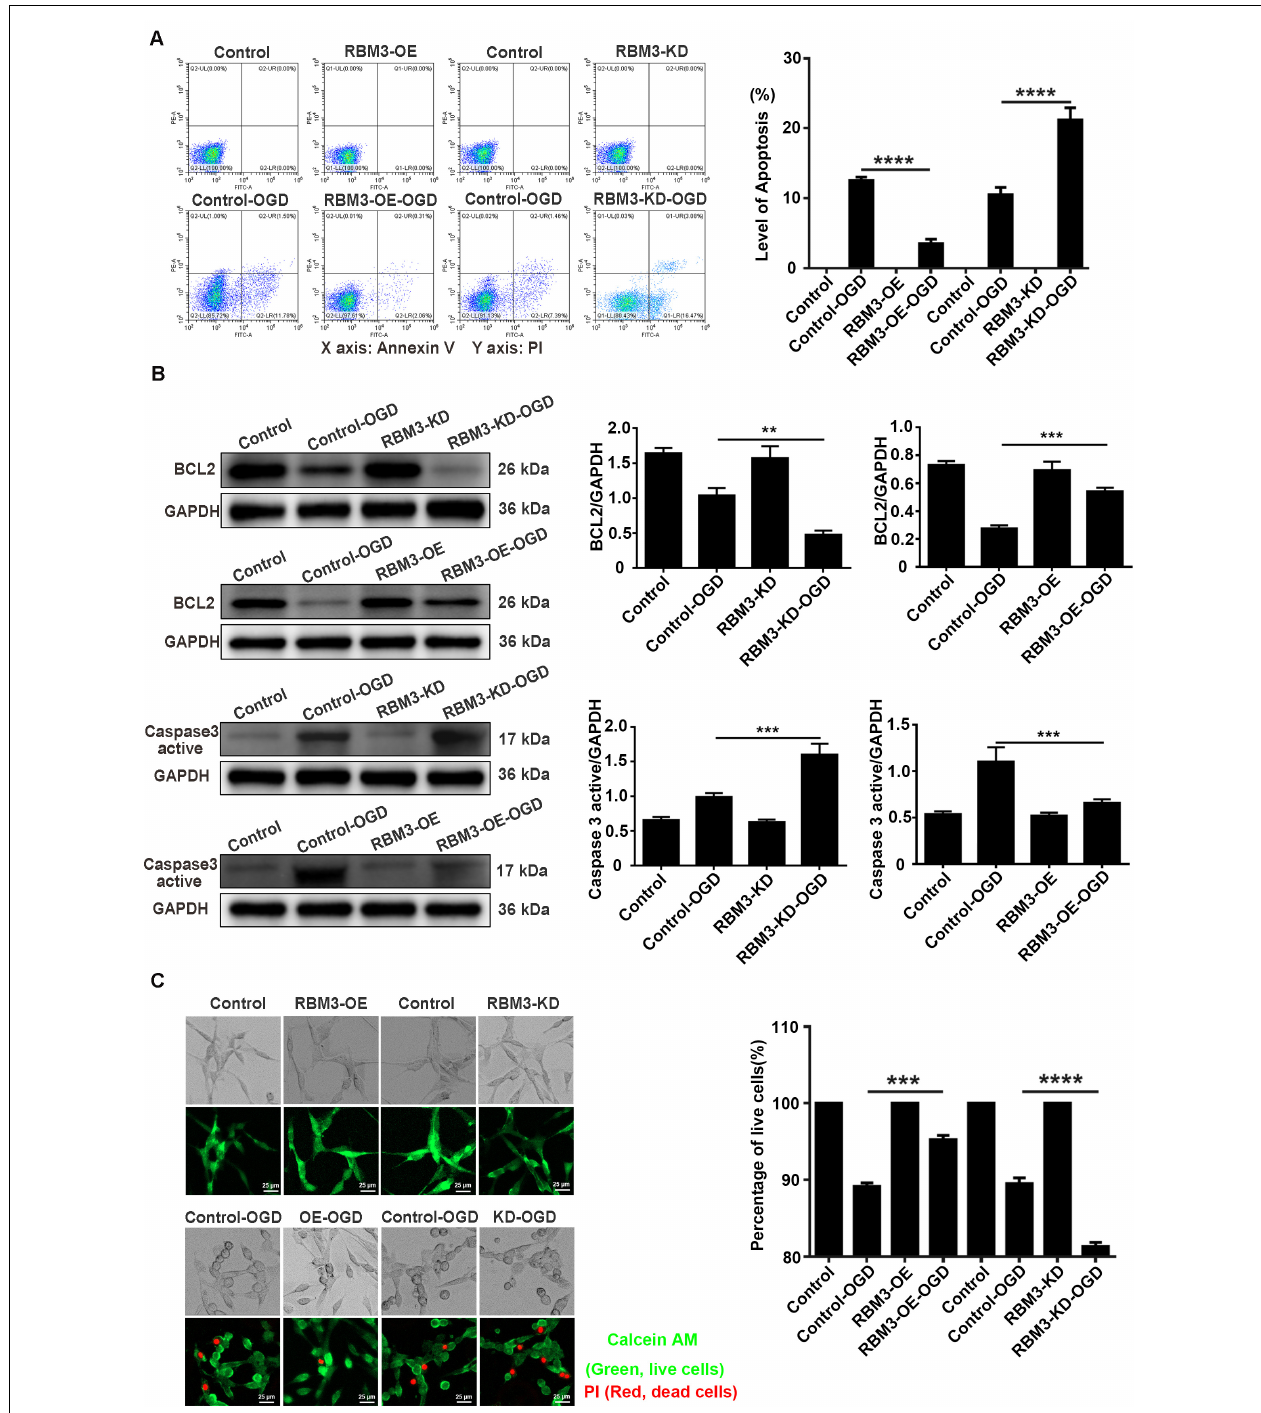
FIGURE 7 | The apoptosis level and percentage of live cells in RBM3 overexpressing cells and RBM3 knockdown cells under 6 h of OGD/R injury. (A) Apoptosis levels of cells were detected by the annexin V-FITC/PI double staining assay. A total of 10,000 cells were counted for each flow cytometry analysis. ****, compared with control-OGD group; P < 0.0001. X-axis: Annexin V; Y-axis: PI. (B) BCL2 and Caspase 3 active protein expression in RBM3 overexpressing cells and RBM3 knockdown cells under 6 h of OGD/R injury. The western blotting assay was used to detect the protein expression BCL2 and Caspase 3 active. ** , compared with control-OGD group; P < 0.01; *** , compared with control-OGD group; P < 0.001. (C) The percentage of live cells in RBM3 overexpressing cells and RBM3 knockdown cells under 6 h of OGD/R injury. Live/Dead cell staining was used to measure the percentage of live cells. Cells were stained with Calcein AM (green; live cells) and PI (red; dead cells). *** , compared with control-OGD group; P < 0.001; **** , compared with control-OGD group; P < 0.0001. Scale bars: 25 µ